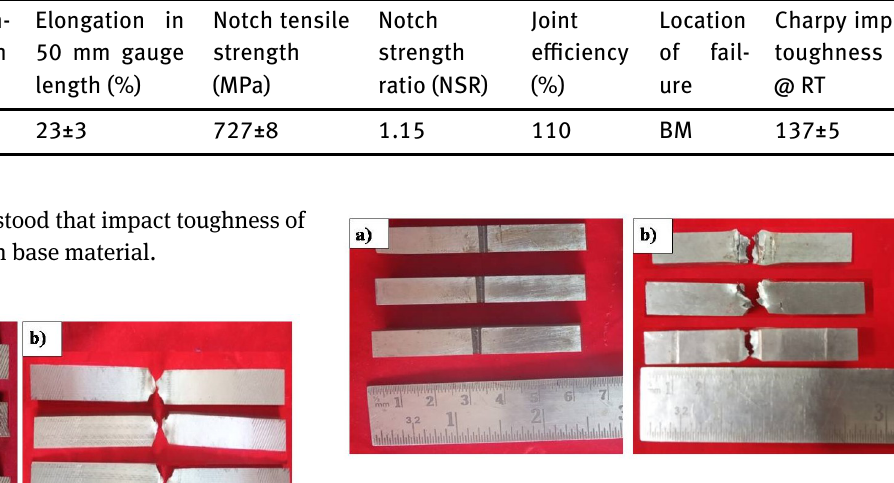
Figure 10: Photographs of Impact Test Specimen: a) Impact tough- ness specimen (before Testing), b) Impact toughness specimen (After